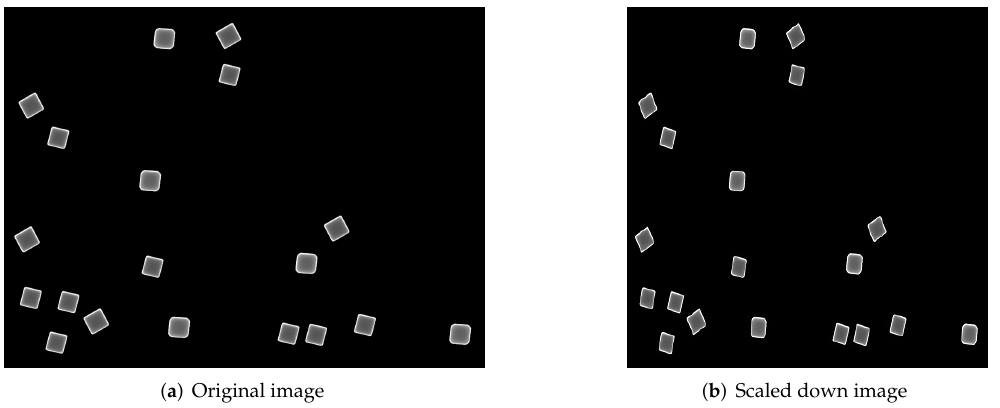
Figure 6. An example of a synthetic image used for training in its original and scaled down resolutions, the latter being the one the size of the input layer for the YOLO neural